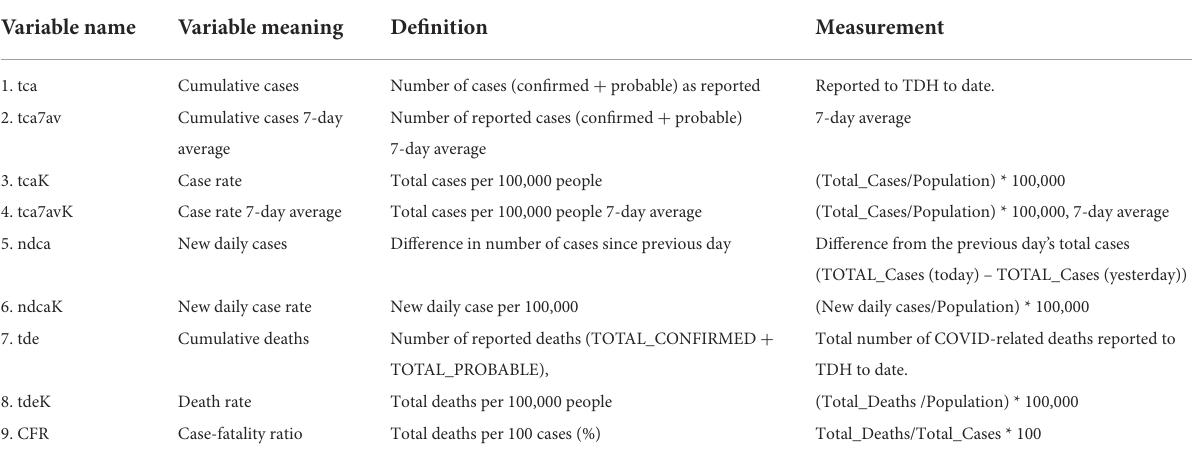
TABLE 1 Health outcomes analyzed in the